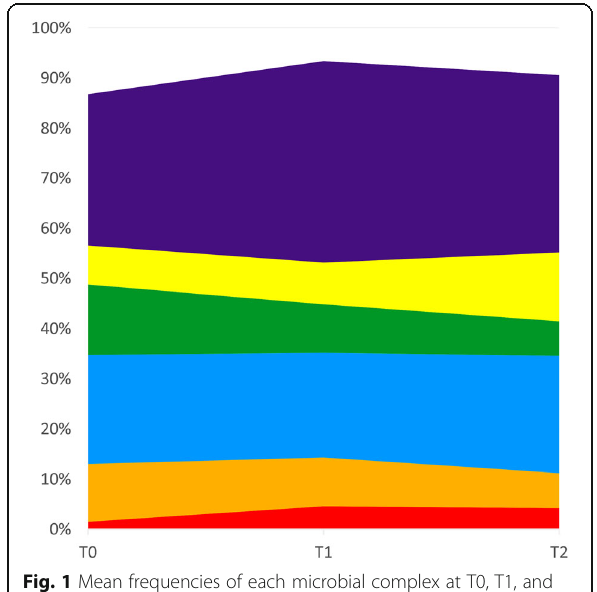
Fig. 1 Mean frequencies of each microbial complex at T0, T1, and T2. The colors represent different complexes